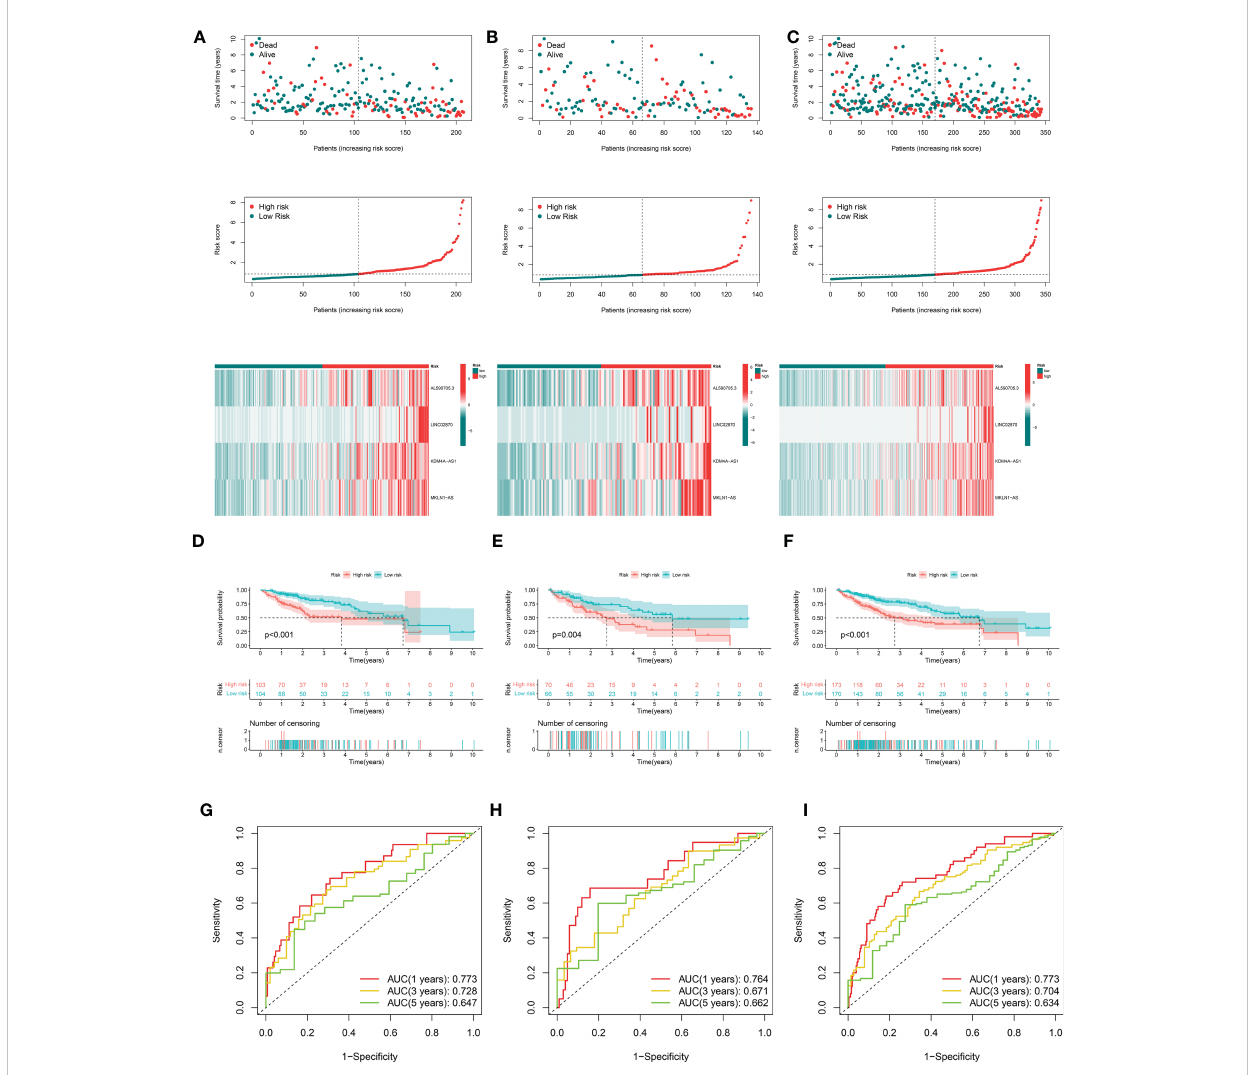
FIGURE 2 Evaluation and validation of cuproptosis-related lncRNA signatures for overall survival in patients with HCC in three datasets. Risk scores and expression pro fi les of seven-lncRNA signatures in the high- and low-risk groups showed in the training cohort (A) , testing cohort (B) , and entire cohort (C) Kaplan – Meier survival and ROC analyses in the training cohort (D, G) , testing cohort (E, H) , and entire cohort (F, I) ,